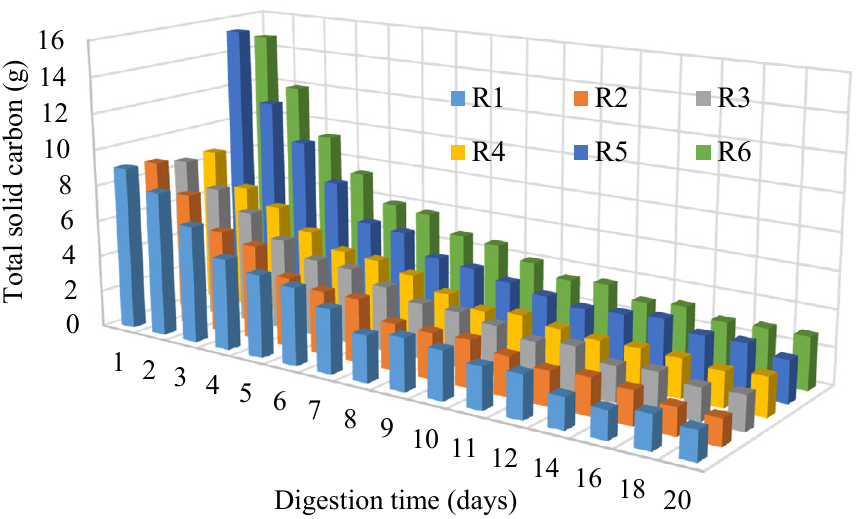
Fig. 2: The decay of total solid carbon during anaerobic digestion